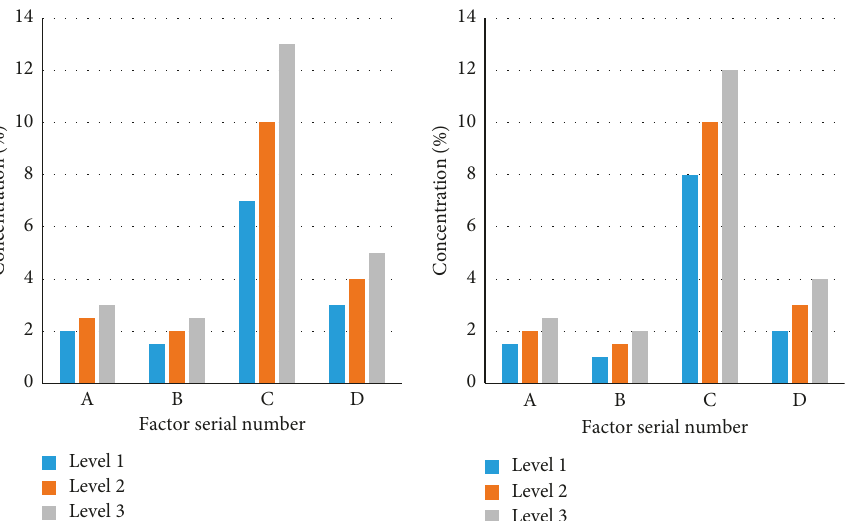
Figure 6: Experimental factor level.